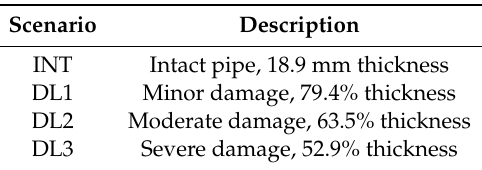
Table 2. Damage severity at different locations on the pipe.